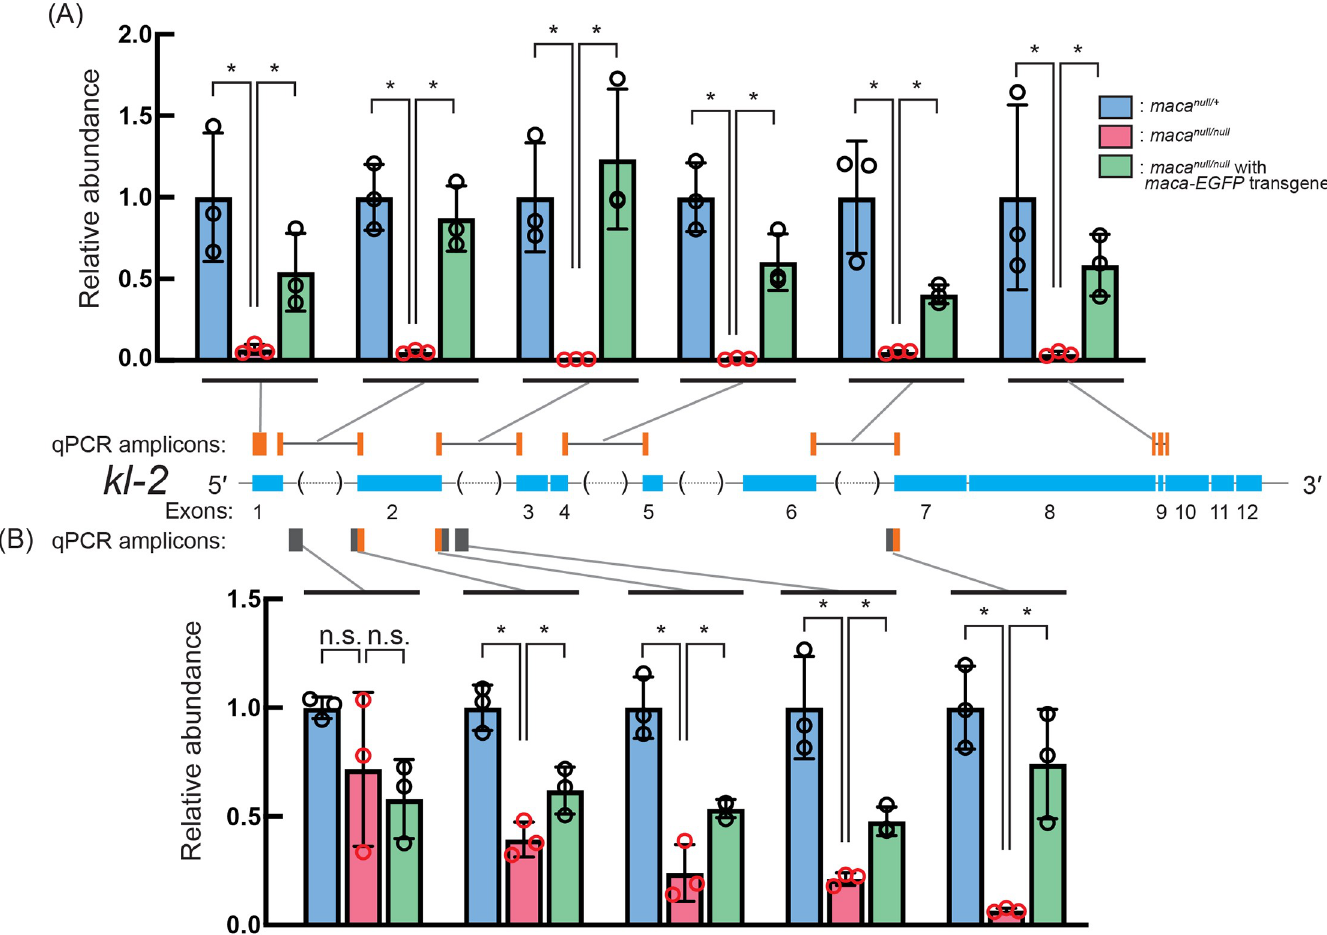
Fig 7. Quantification of kl-2 transcripts by RT-qPCR show their reduction in maca null/null testes. Quantification of kl-2 transcripts in testis RNA by RT-qPCR. The RT step was performed with random hexamer primers. (A) qPCR amplicons targeted by designed primer sets are indicated by orange bars. The primers span exon-exon junctions to amplify only spliced transcripts, except for the first amplicon, which targets exon 1. Black lines indicate intron regions not included in the amplicons. (B) qPCR amplicons targeted by designed primer sets are indicated by gray and orange bars, which indicate intron and exons regions, respectively. At least one primer in each primer set targets an intron and therefore the primer sets target kl-2 transcripts before splicing (pre-mRNAs). Data were normalized to actin5C mRNA and the means of maca null/+ . Mean +/- SD (n = 3 biological replicates). P-values < 0.05 (Student’s t-test, unpaired, two-tailed) are indicated by �